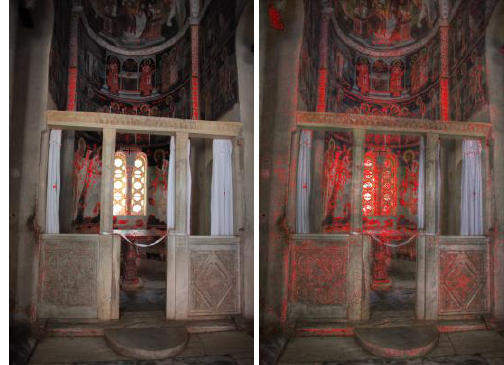
Figure 4: Features detected with FAST (a) on the SDR image (14073 points) and (b) on the HDR image (68001 points).